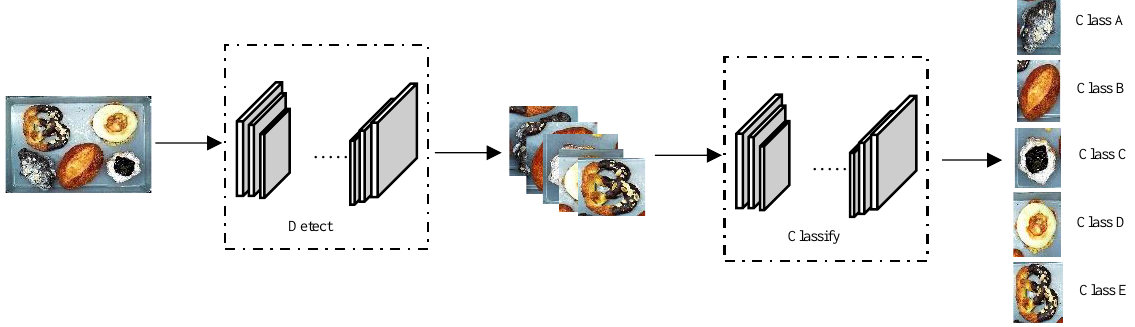
Figure 1. DN detection architecture. The image is input to the detection network to obtain the object location and the major category firstly, and then the obtained object is cropped and input to the classification network to obtain the final result.